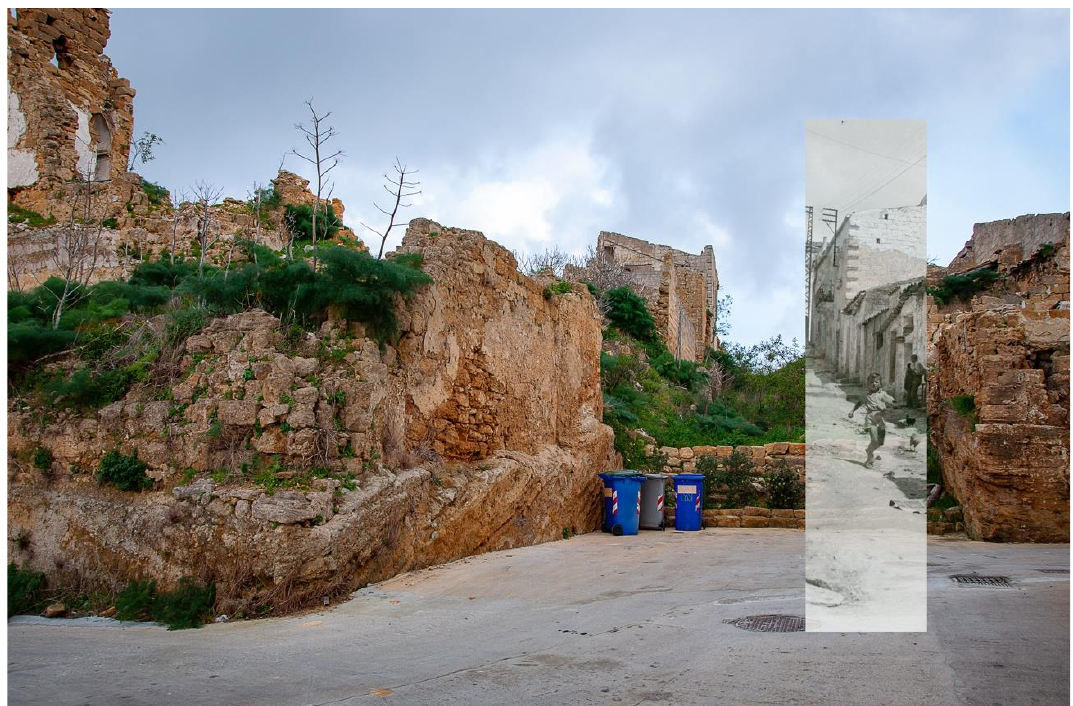
Figure 19. Santa Margherita di Belìce (Photo: Scafidi for L’Ora, Archivio de L’Ora, Biblioteca Regionale Siciliana “Alberto Bombace”, Palermo) and Ruins of the Chiesa Madre (Photo by the authors, Montevago 2020).